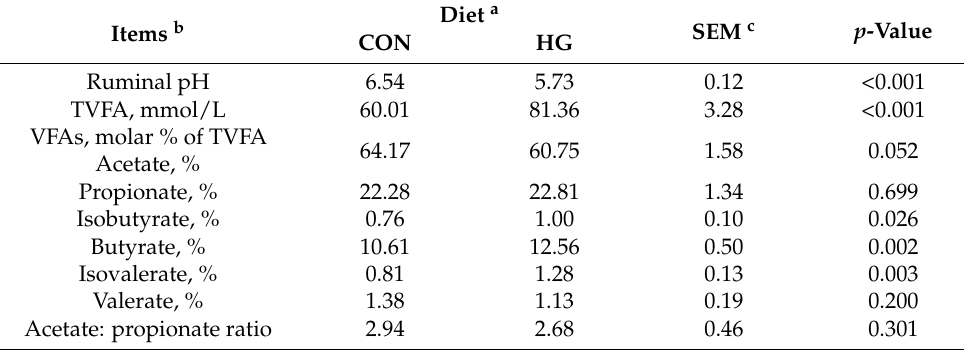
Table 3. Effects of high-grain diet on the rumen fermentation parameters in